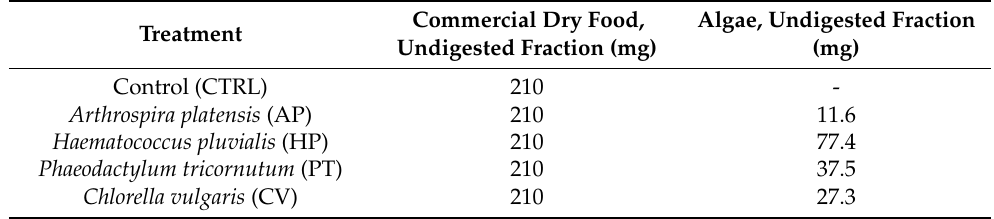
Table 2. Amount of undigested fraction of the commercial dry food and microalgae that were added to each bottle. Each bottle contained 21 mL of fecal